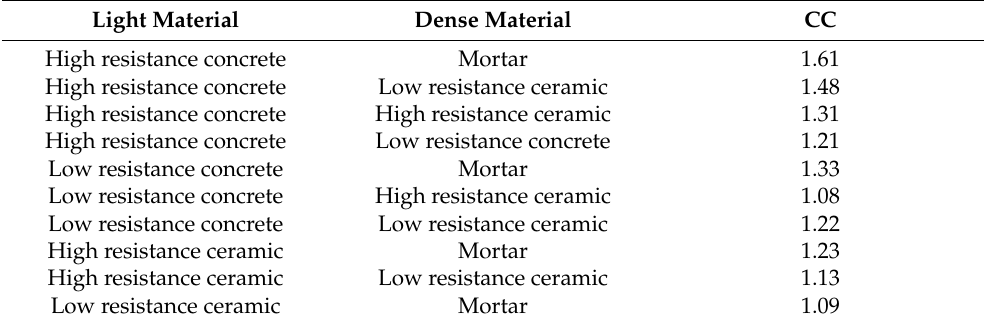
Table 3. Concentration criteria (CC) in water (see Equation (1)) for interactions of different aggregates. Light Material Dense